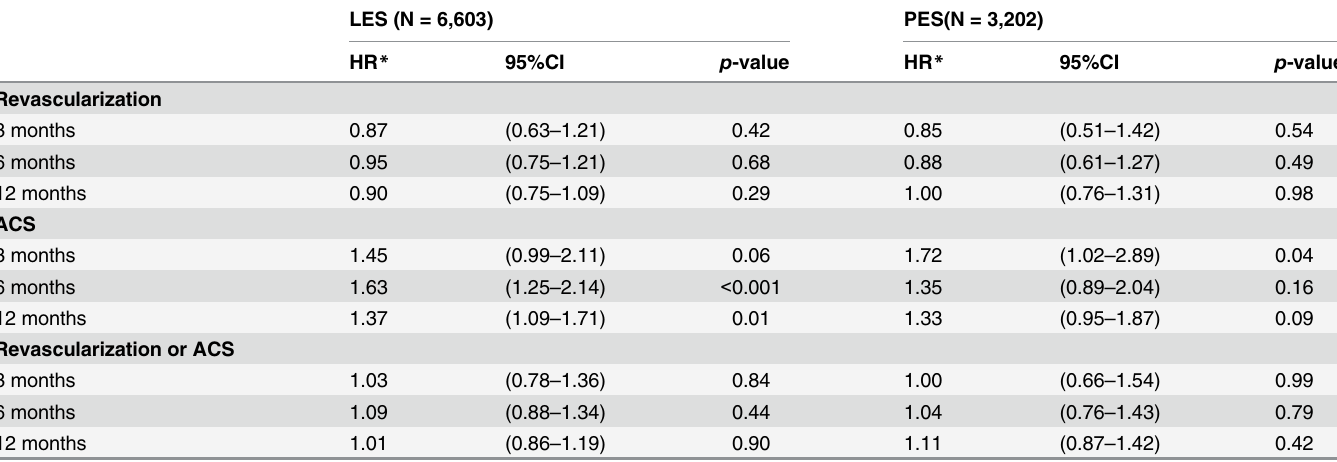
Table 3. Effect of exposure to clopidogrel versus clopidogrel plus PPI after DES